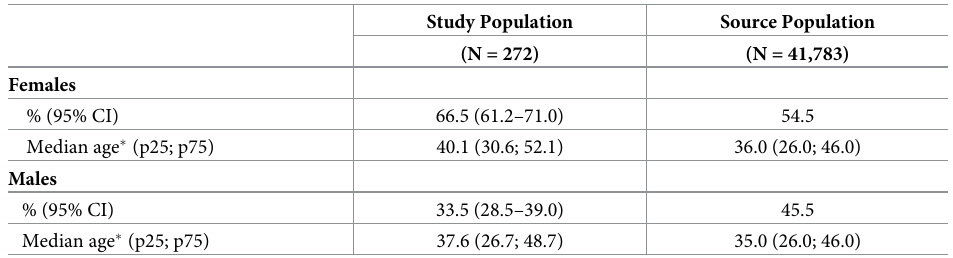
Table 1. Distribution of sex and age for the source and study